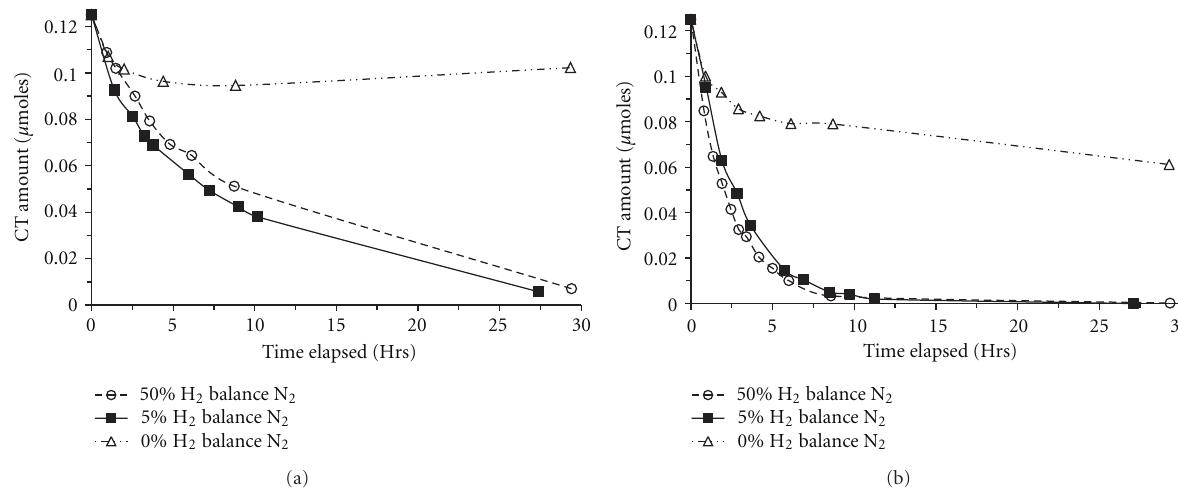
Figure 5: Carbon tetrachloride (CT) transformation curves obtained with (a) Pd/Foam and (b) Pd/CNT/Foam catalyst and varying hydro- gen concentration.